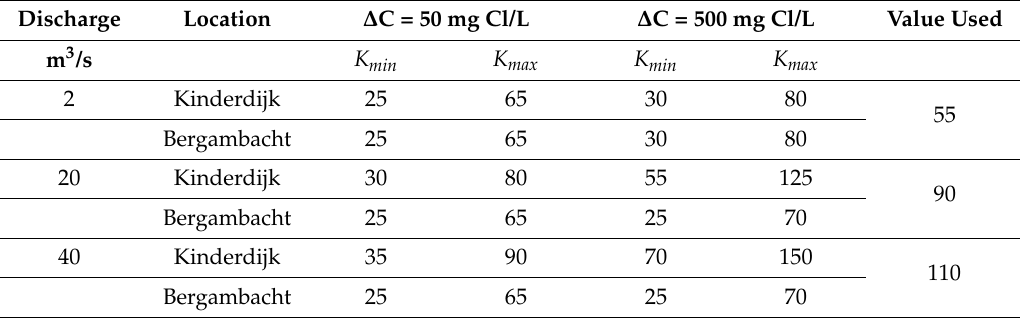
Table 2. Overview of the values for the dispersion coefficient K for Kinderdijk and Bergambacht as presented in [7]. All numbers rounded to fives. ∆ C is the increase in chloride concentration with respect to the riverine concentration. K min and K max are the minimum and maximum estimate for the dispersion coefficient. Estimates for 40 m 3 /s were calculated following the same method as in [7]. Discharge Location ∆ C = 50 mg Cl/L ∆ C = 500 mg Cl/L Value Used m 3 /s K